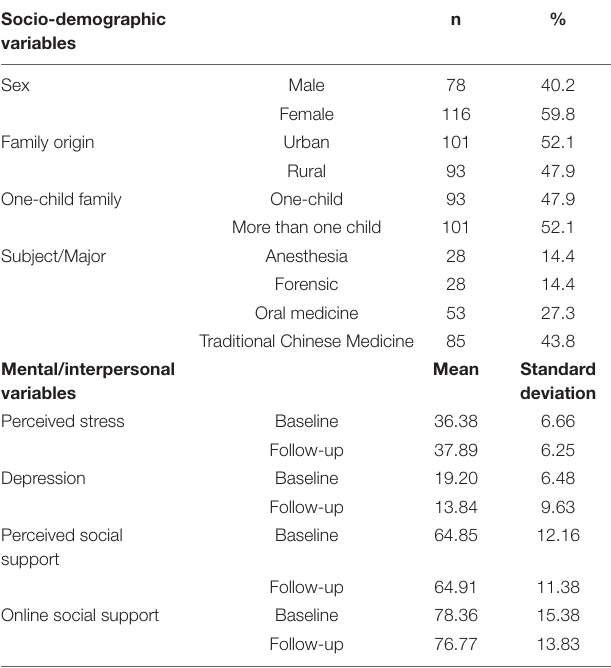
TABLE 1 | Background characteristics of the participants ( N = 194).